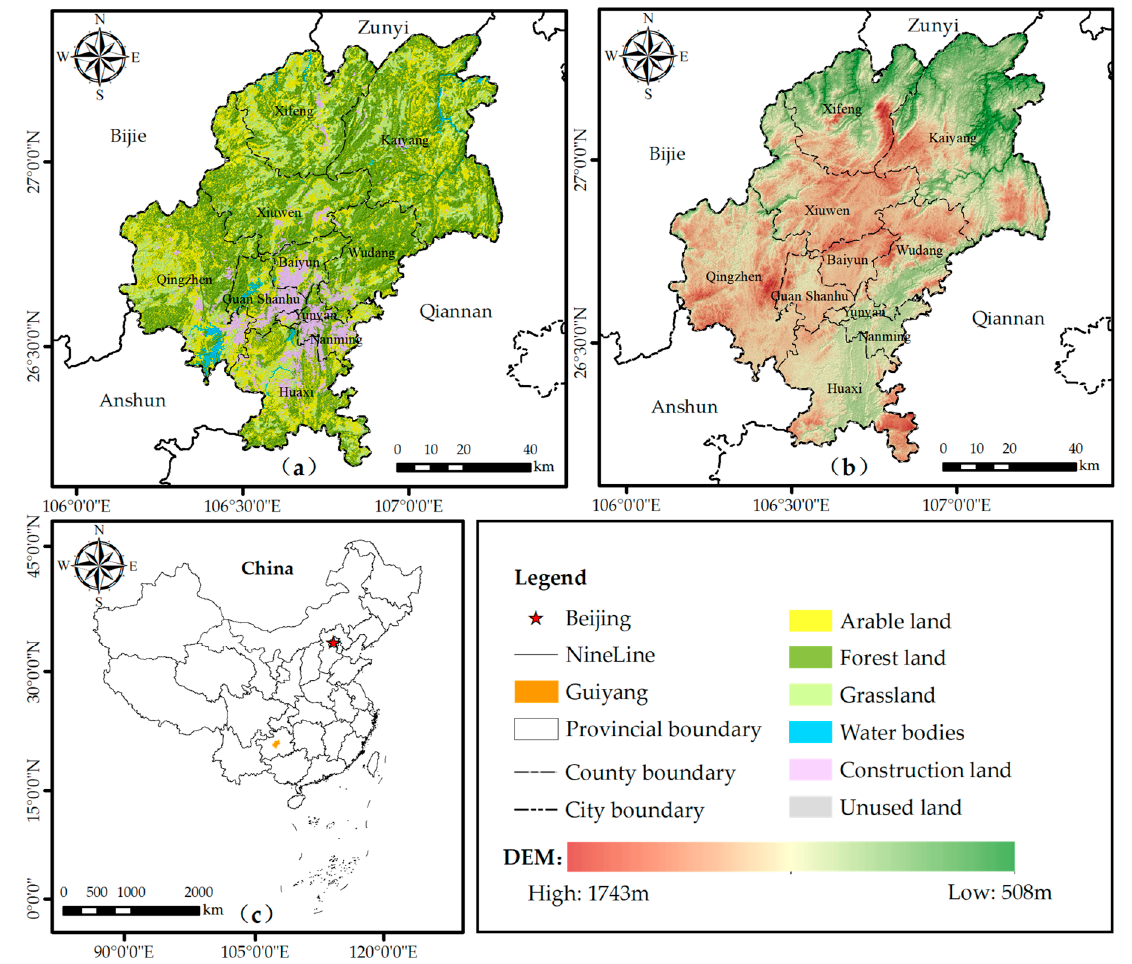
Figure 1. Location, administrative divisions, land use, and elevation of Guiyang city. (a) Land use in Guiyang city in 2020; (b) elevation of Guiyang city; (c) location of Guiyang city in China.